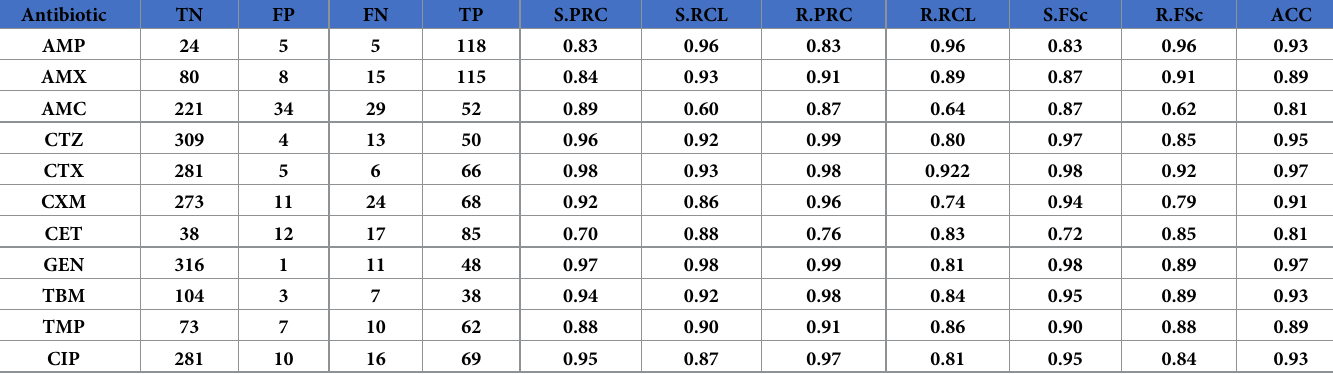
Table 1. Prediction metrics on held out data for the best performing gradient boosted decision trees model.